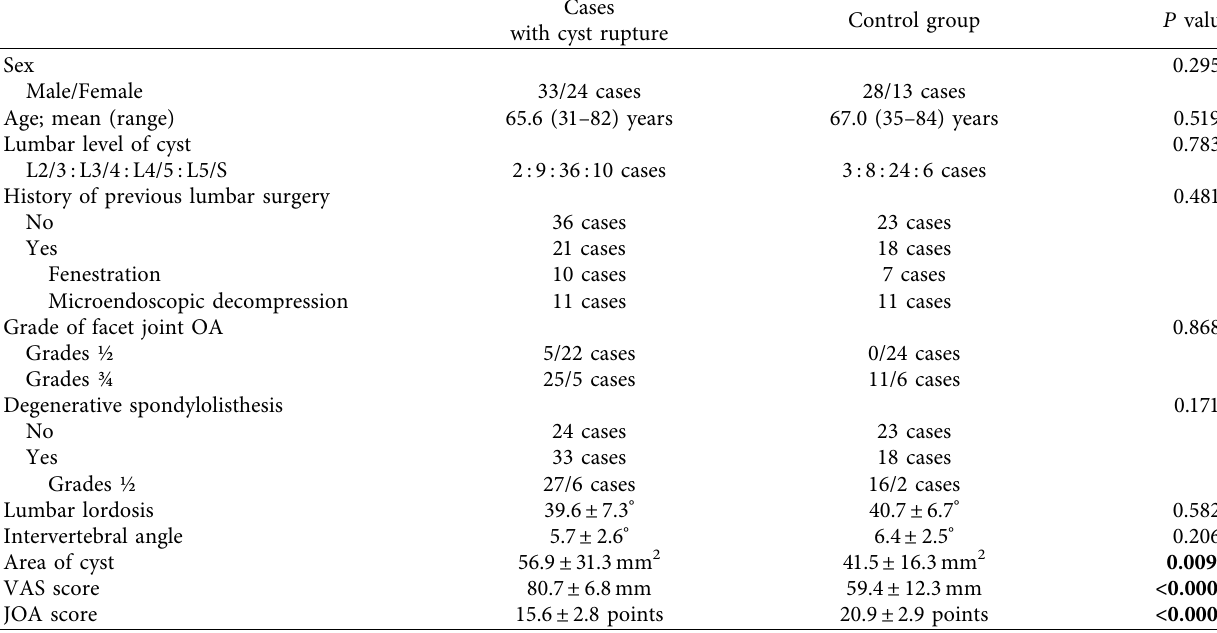
Table 1: Demographic data of patients undergoing cyst rupture ( N � 57) and those included in the control group ( N �